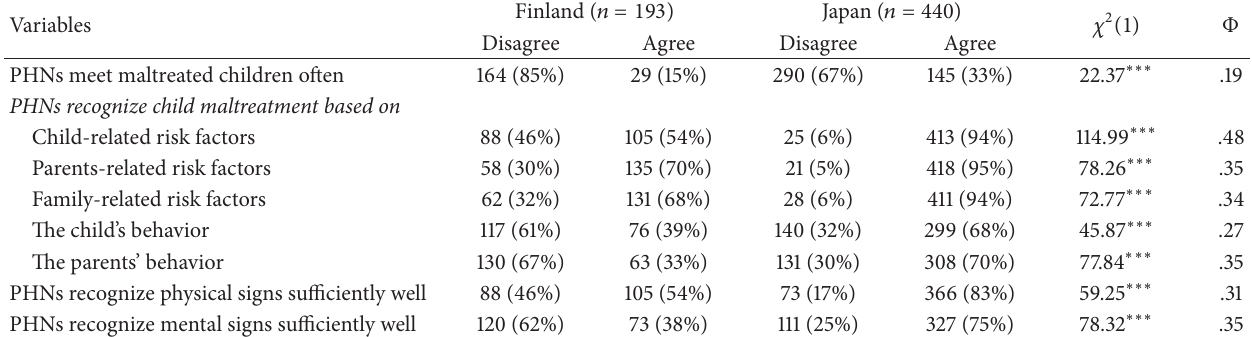
Table 2: Identification of child